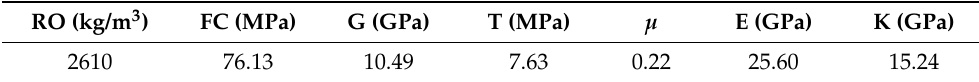
Table 2. The basic mechanical parameters of